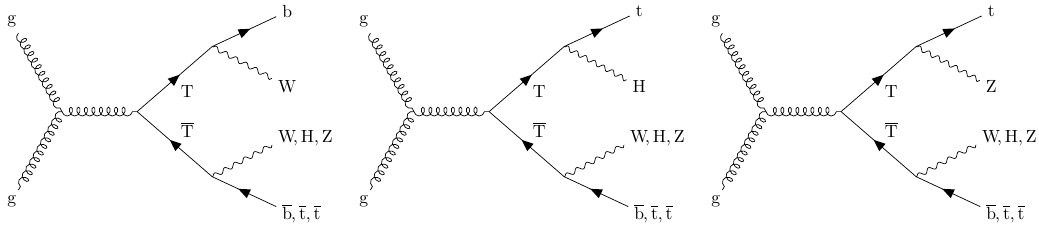
Figure 1 . Examples of leading-order Feynman diagrams showing production of a TT pair with the T quark decaying to bW (left), tH (middle), and tZ